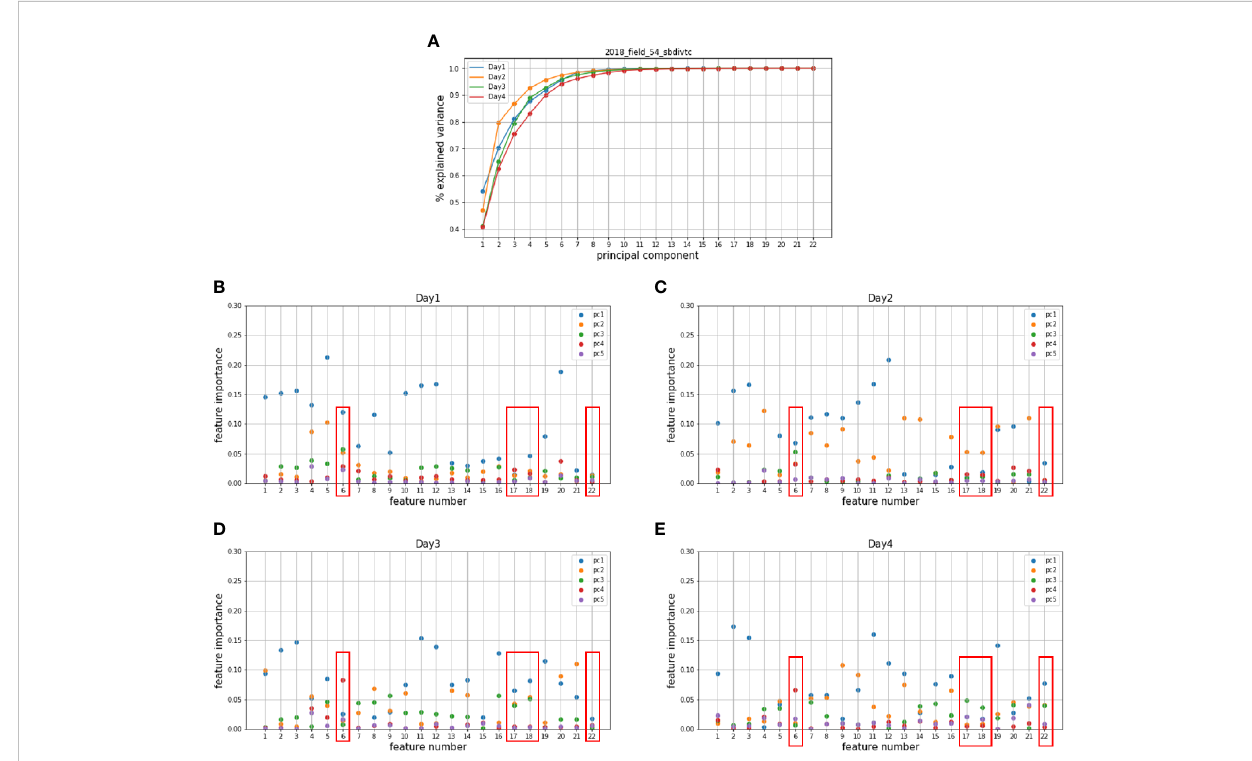
FIGURE 5 Principal components of the hyperspectral features in (A) 2018 Tc panel and the corresponding importance of hyperspectral features on (B) the 1st, (C) the 2nd, (D) the 3rd, (E) the 4th dates which represents four different growing